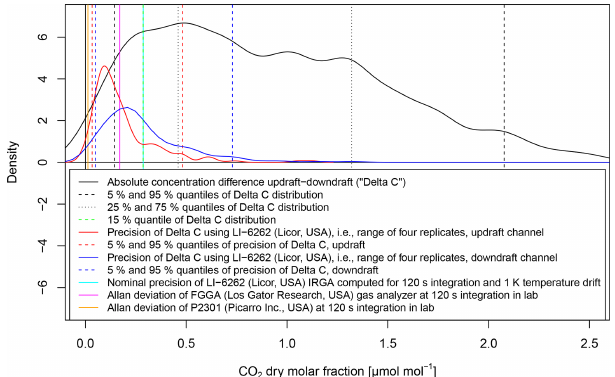
Figure 20. Density distributions and selected probabilities of the trace gas concentration difference signal and of the measurement uncertainties, and gas analyzer precision. The signal is the differ- ence in molar fraction between accumulated updrafts and down- drafts (black line). The uncertainty of the measurements is ex- pressed as the range of four replicated samples of the updraft and downdraft concentration, in red and blue, respectively. Verti- cal dashed lines indicate various probabilities of the above distri- butions. Vertical solid lines indicate the nominal precision of the LI-6262 (LI-COR, USA) infrared gas analyzer used in this study, calculated for an integration time of 120s (cyan). Precision of two types of laser spectrometers are also shown for reference: Allan deviation of FGGA (Los Gatos Research, USA), in magenta, and G2301 (Picarro, USA), in orange, both determined in the labora- tory.